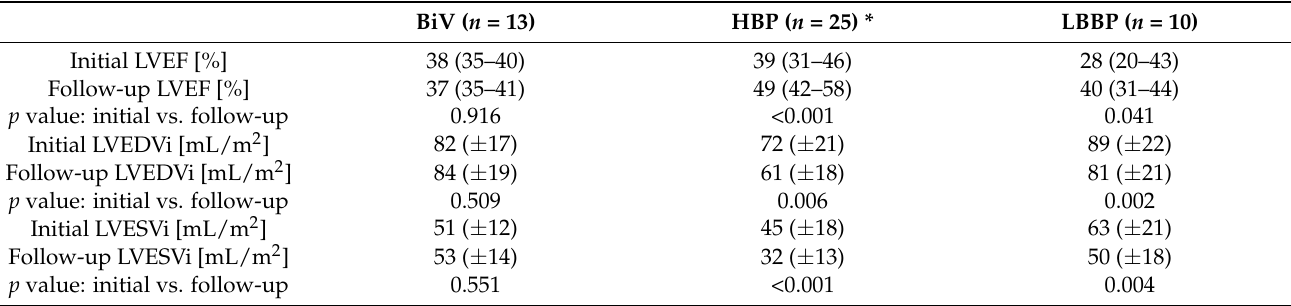
Table 5. Echocardiographic outcomes of patients by pacing modality at baseline and follow-up.